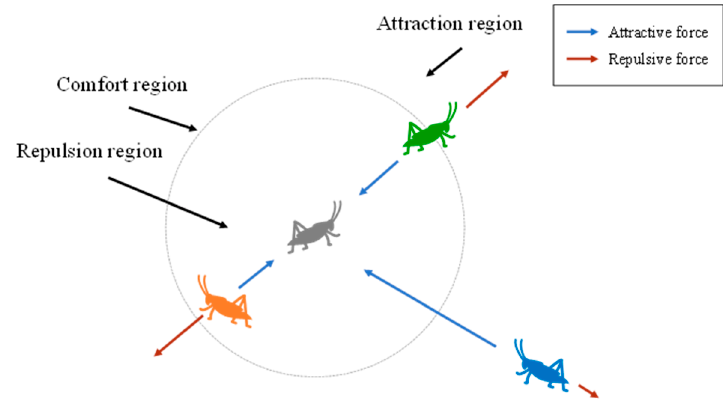
Figure 1. The figure of the interaction between individual